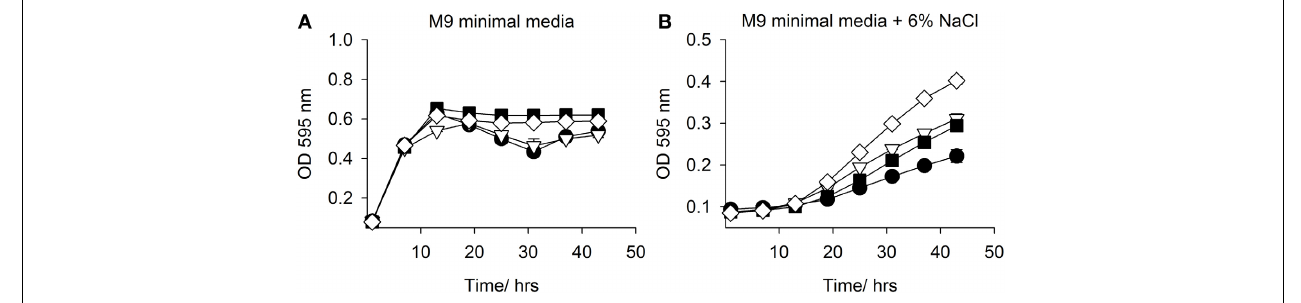
FIGURE 6 | Growth in M9minimal media with NaCl + / − L-carnitine. Growth of EPI300::pCI372 and EPI300::pCI372- sdtR in (A) M9minimal media and (B) M9minimal media + 6% NaCl. Legend: E.